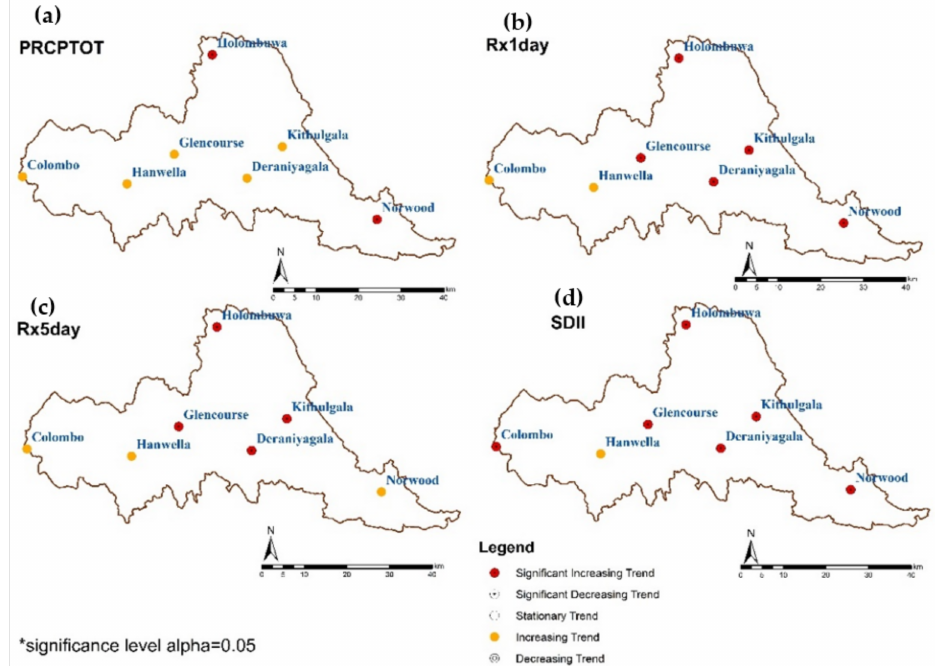
Figure 7. The spatial and temporal variability of the trend of non-threshold EPIs in the last 40 years in the study area. ( a ) The spatial and temporal trend of PRCPTOT, ( b ) the spatial and temporal trend of Rx1day, ( c ) the spatial and temporal trend of Rx5day, and ( d ) the spatial and temporal trend of SDII.